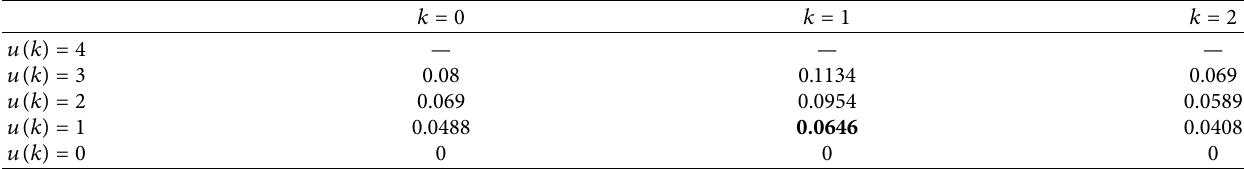
Table 4: Values of L ( u ( k ) ,k ) for various values of u ( k ) .